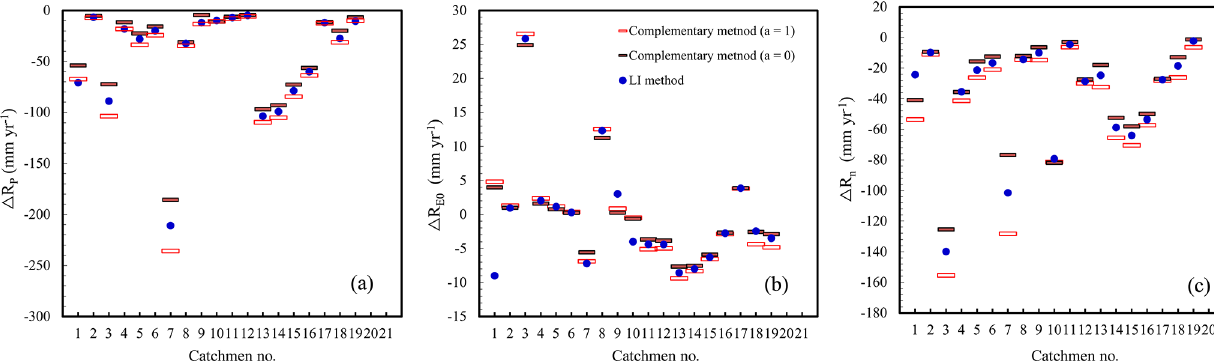
, and (c) (cid:49)R n by the LI method with the upper and lower bounds given by the complementary 0 , and (cid:49)R n reach their bounds when a is 0 or 0